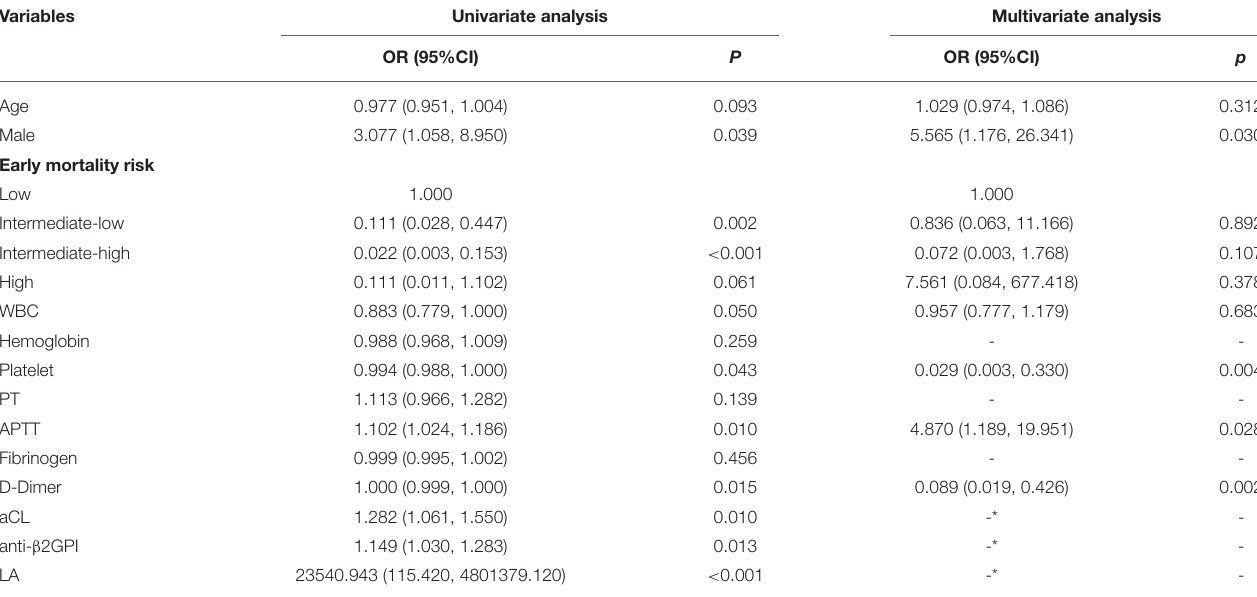
TABLE 5 | Univariate andmultivariate logistic analysis of variables associated with APS-PE. Variables